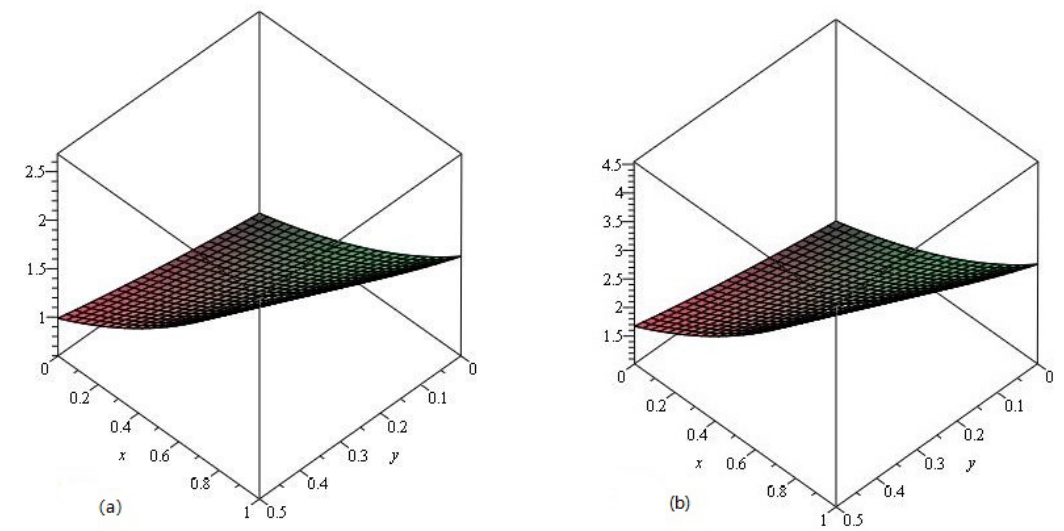
Figure 8. The ( a ) Exact and ( b ) LADM solutions of υ ( x , y , t ) of Example 4 at γ = 1.